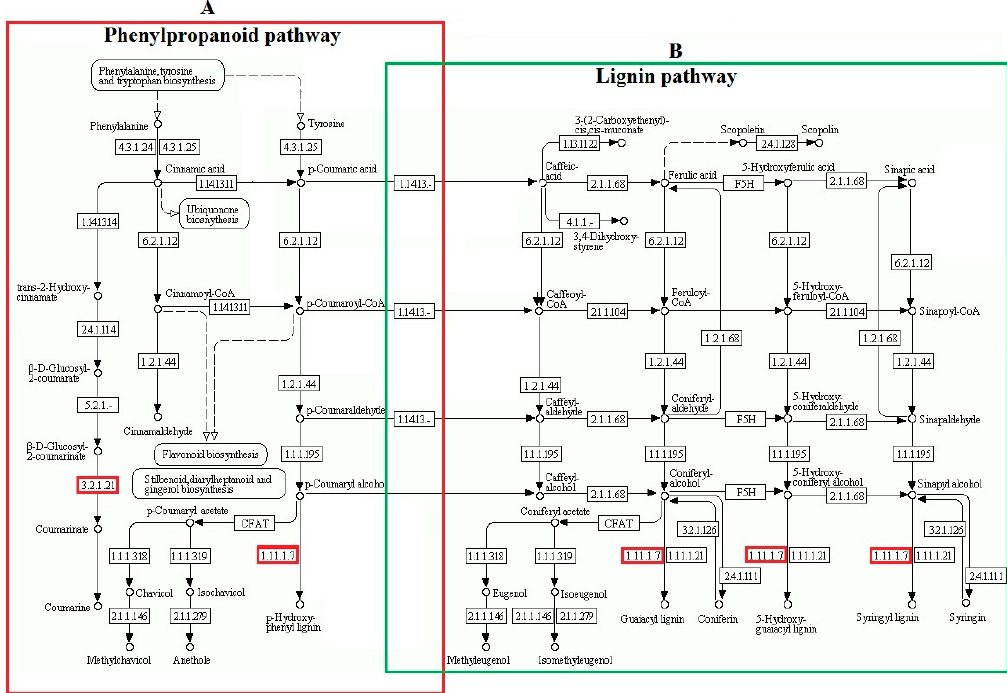
Figure 7. DAPs involved in phenylpropanoid and the lignin pathway of winter turnip rape. ( A ) Phenylpropanoid pathway. ( B ) Lignin pathway. The colored enzyme codes are noted as follows: Gly-Asp-Ser-Leu (GDSL) esterase/lipase (EC: 3.2.1.21), Peroxidase C3 and Peroxidase A2 (EC: 1.11.1.7).